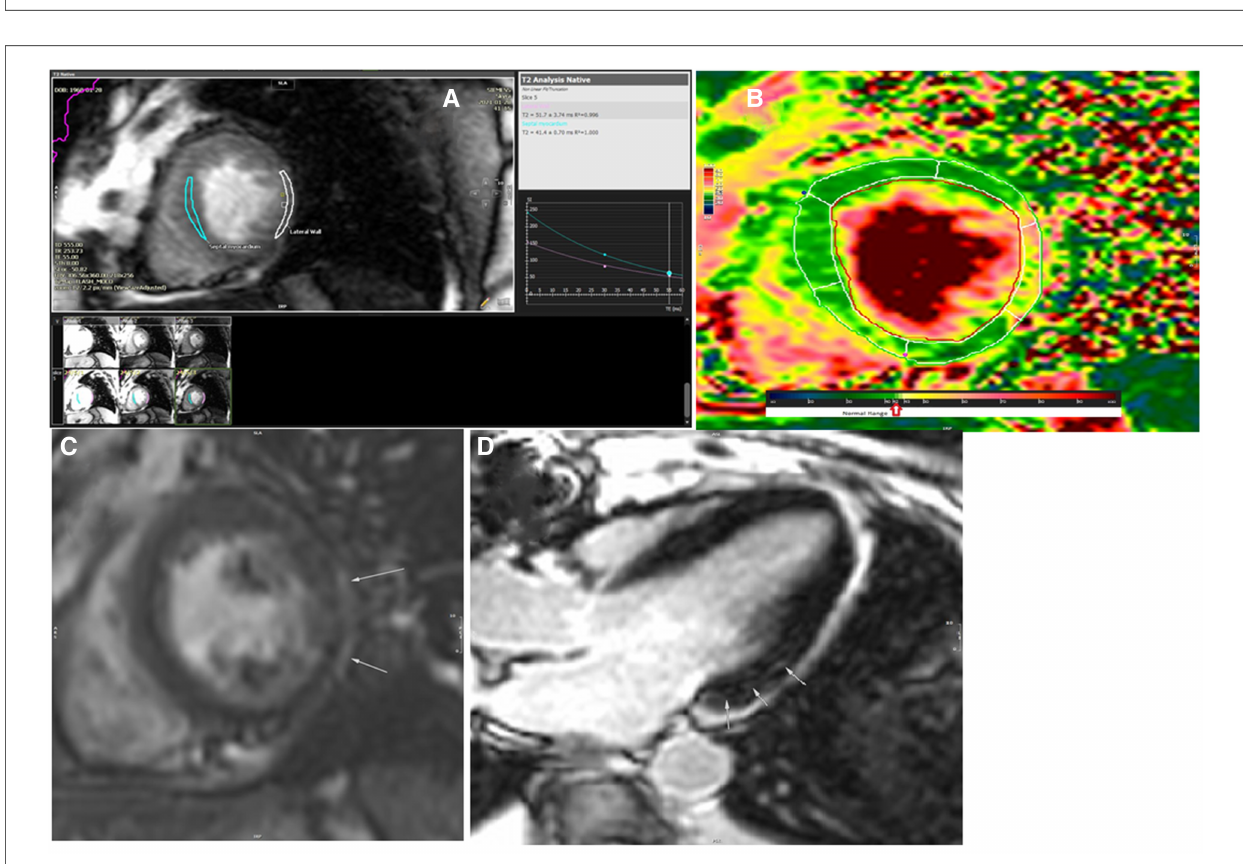
FIGURE 4 The results of cardiac magnetic resonance imaging after the radiation ( A – D ). ( A ) T2 analysis of mid-septal and mid-lateral segments of the left ventricle revealed prolongation of T2 relaxation time in the mid to apical segments of the lateral wall (52 ms). ( B ) T2 map image of the left ventricle in short axis view showed abnormal T2 value in the mid-lateral segment of the left ventricle. ( C ) Delayed postcontrast image of the left ventricle in short axis view showed a subepicardial rim of late gadolinium enhancement on the lateral wall of the left ventricle. ( D ) Delayed postcontrast image of the left ventricle in long axis three-chamber axis view revealed small focal subepicardial to mid-wall patches of late gadolinium enhancement in the basal inferolateral